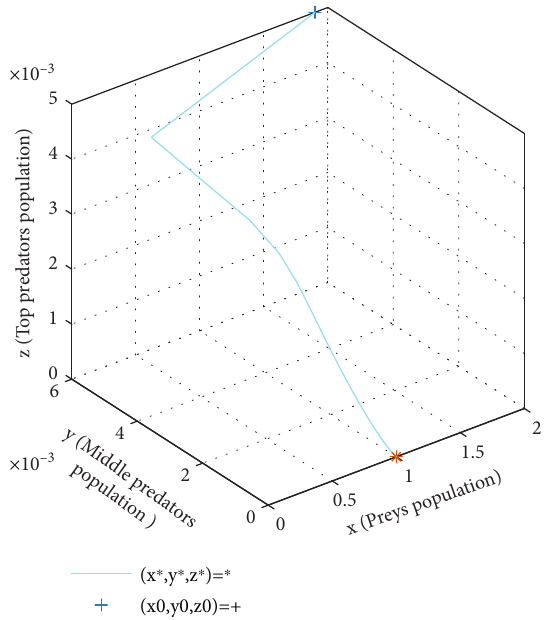
Figure 2: The plot shows the local stability of E 1 of the system